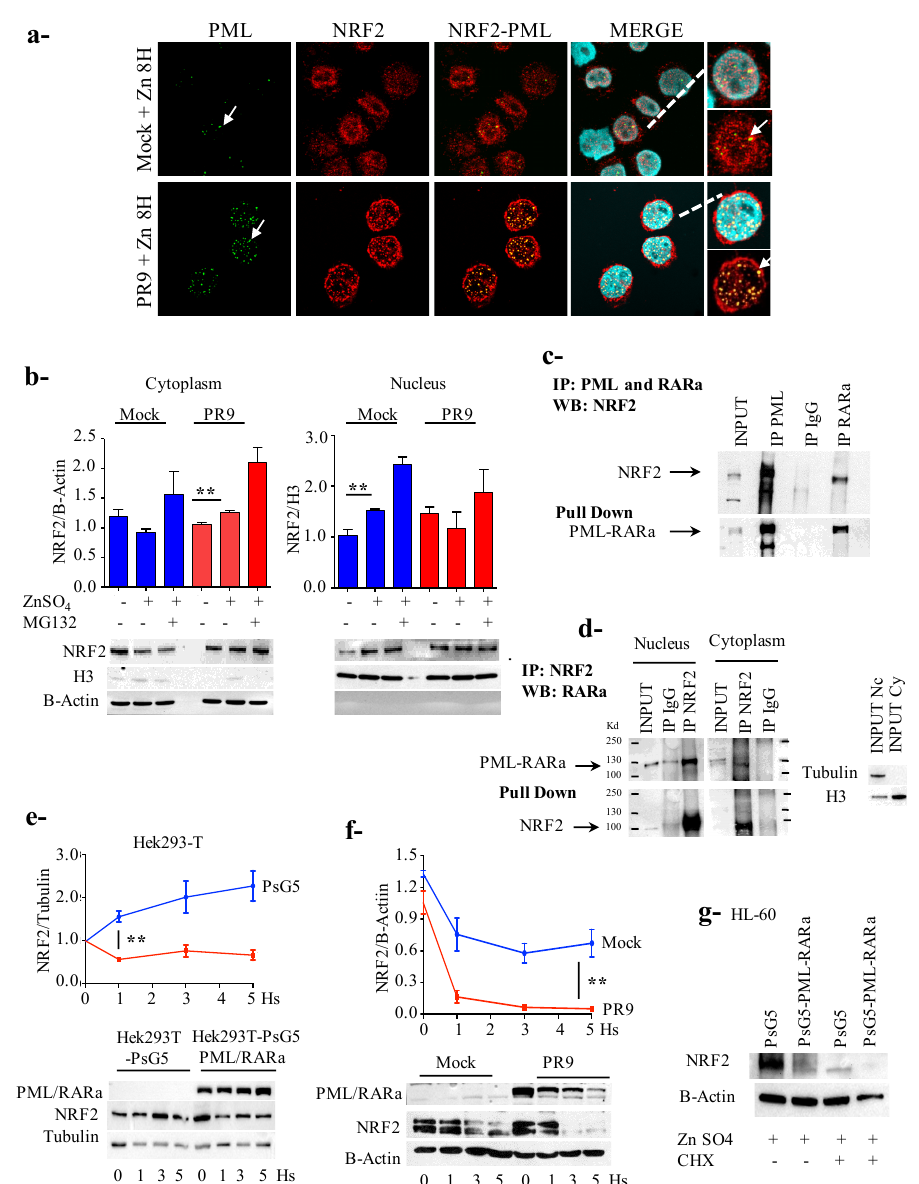
Figure 3. Promyelocytic leukemia / retinoic acid receptor α (PML / RARa) binds to NF-E2 p45-related factor 2 (NRF2), promotes its cytoplasmic degradation and shortens its lifespan. ( a ) At confocal microscopy NRF2 translocates to the cytoplasm eight hours following PML / RARa expression induction. The arrow indicates promyelocytic leukemia-nuclear bodies (PML-NBs). ( b ) Cytoplasmic translocation is confirmed by nuclear / cytoplasmic fractionation. ( c ) PR9 cells where treated with ZnSO 4 100 µ M for four hours, after that cross-immunoprecipitation experiments where done showing that PML / RARa interacts with NRF2. ( d ) Co-immunoprecipitation of NRF2 in the cytoplasm and nucleus using PR9 cells previously treated with ZnSO 4 for four hours demonstrated an interaction between PML / RARa and NRF2 in both fractions. ( e ) Hek293T cells were transfected with pS5G or pS5G-PML / RARa, after 24 h where treated with ZnSO 4 100 µ M to evaluate the e ff ect of PML / RARa on NRF2 induction. PML / RARa inhibit the expression of NRF2 ( f ) PR9 cells and the control Mock cells were treated with ZnSO 4 100 µ M for two hours and then with cycloheximide (CHX) 100 µ g / mL for five hours. Time 0 refers to the moment in which cycloheximide was added, + 2 h after zinc induction. PML / RARa reduce significantly the half-life of NRF2. ( g ) HL60 cells were transfected with pS5G or pS5G-PML / RARa for 24 h, then treated with ZnSO4 100 µ M for two hours and then with CHX 100 µ g / mL for four hours. PML / RARa reduce the half life of NRF2. This experiment was done twice. All the other experiments were done by triplicate. *: p ≤ 0.05; **: p ≤ 0.01 by unpaired t